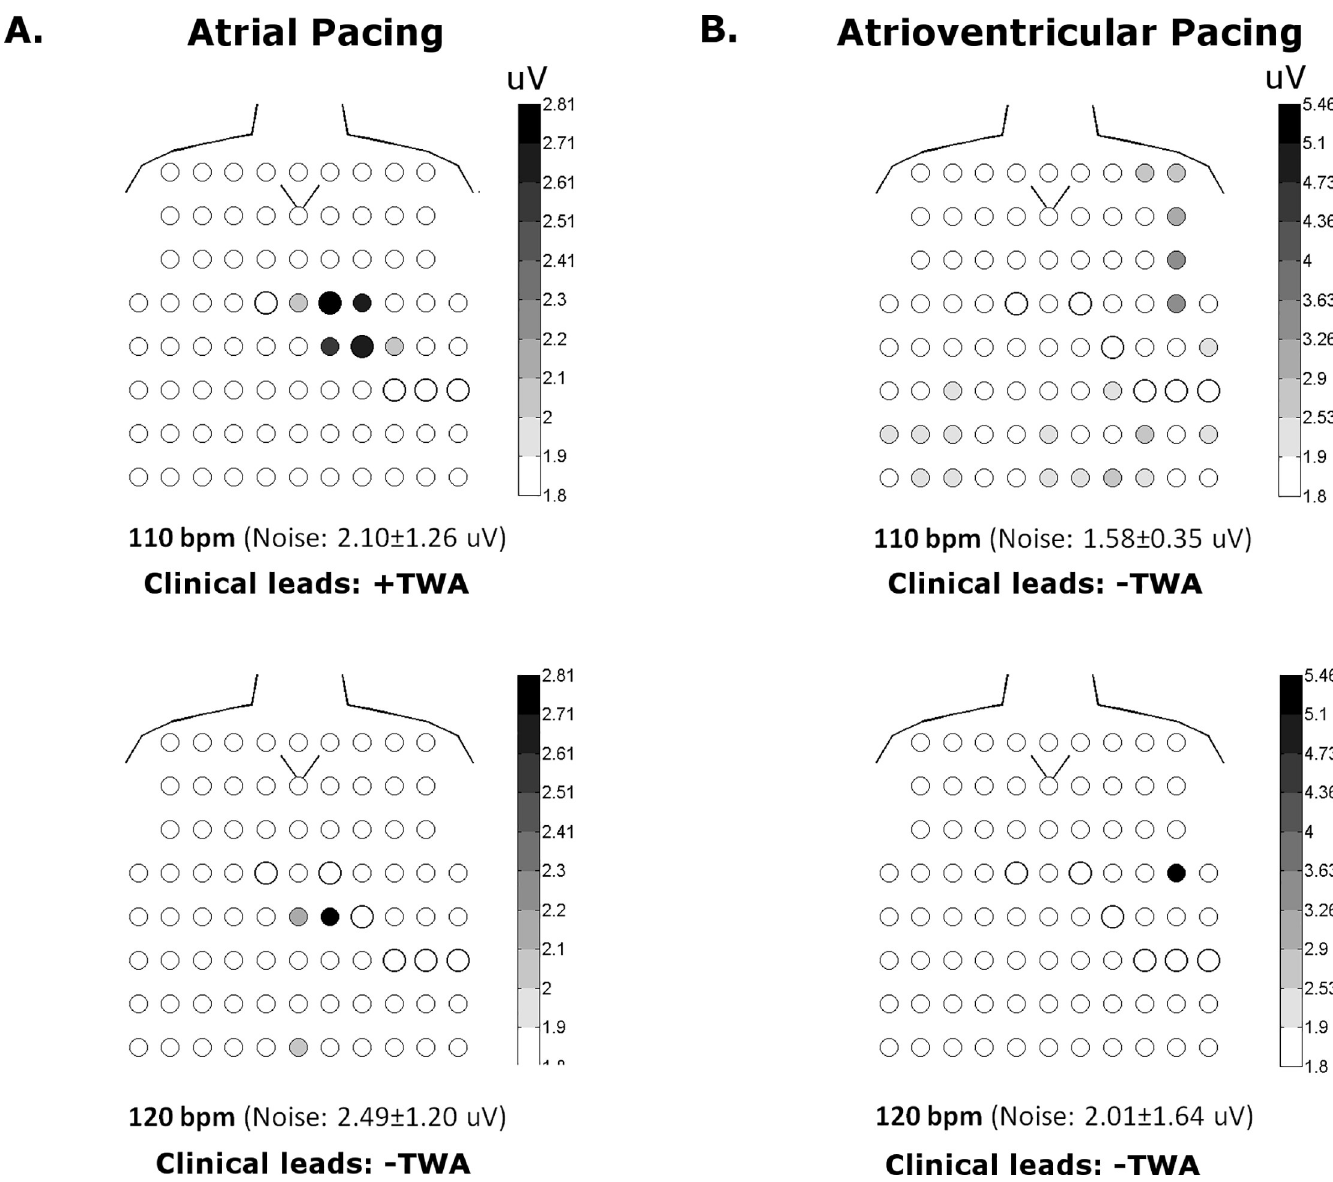
Fig 6. Body torso maps of V alt (uV) in one patient during atrial and atrioventricular pacing. With atrial pacing ( A ), TWA is detected in body torso as well as clinical leads at 110 bpm. However, TWA is no longer detected in clinical leads at 120 bpm, but still evident in body torso leads below the clinical leads. Using clinical leads alone, the clinical TWA classification would still remain positive because pacing rates above 110 bpm are not considered. With atrioventricular pacing ( B ), TWA is no longer detectible in the clinical leads at 110 or 120 bpm, but still present in the body torso. Although this patient would still be classified as clinically +TWA based on atrial pacing 110 bpm alone, changes in pacing rate or mode have altered the body surface distribution of TWA.